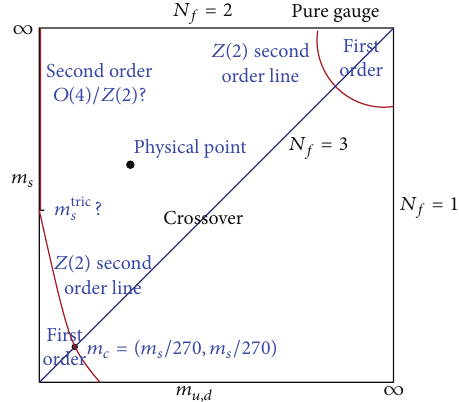
Figure 1: The present status of the Columbia